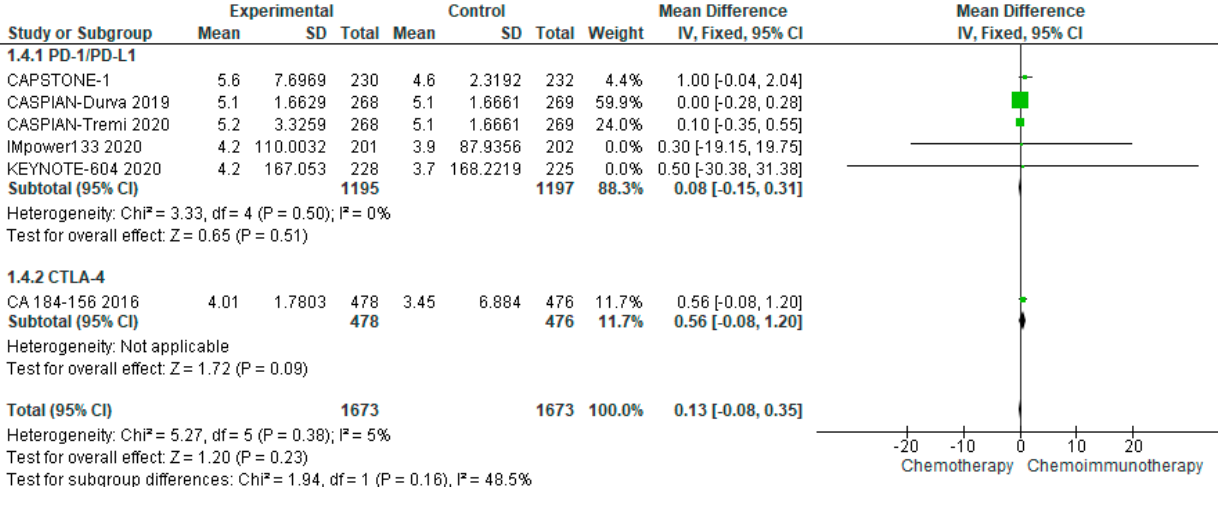
Figure 4. Forest Plot of mean difference in DoR in patients with ES-SCLC and treated with chemo-ICI versus standard chemotherapy. PD–1/PD–L1, programmed death (ligand)–1; CTLA–4, cytotoxic T-lymphocyte-associated protein 4; HR, hazard ratio; CI, confidence interval; IV, inverse variance.